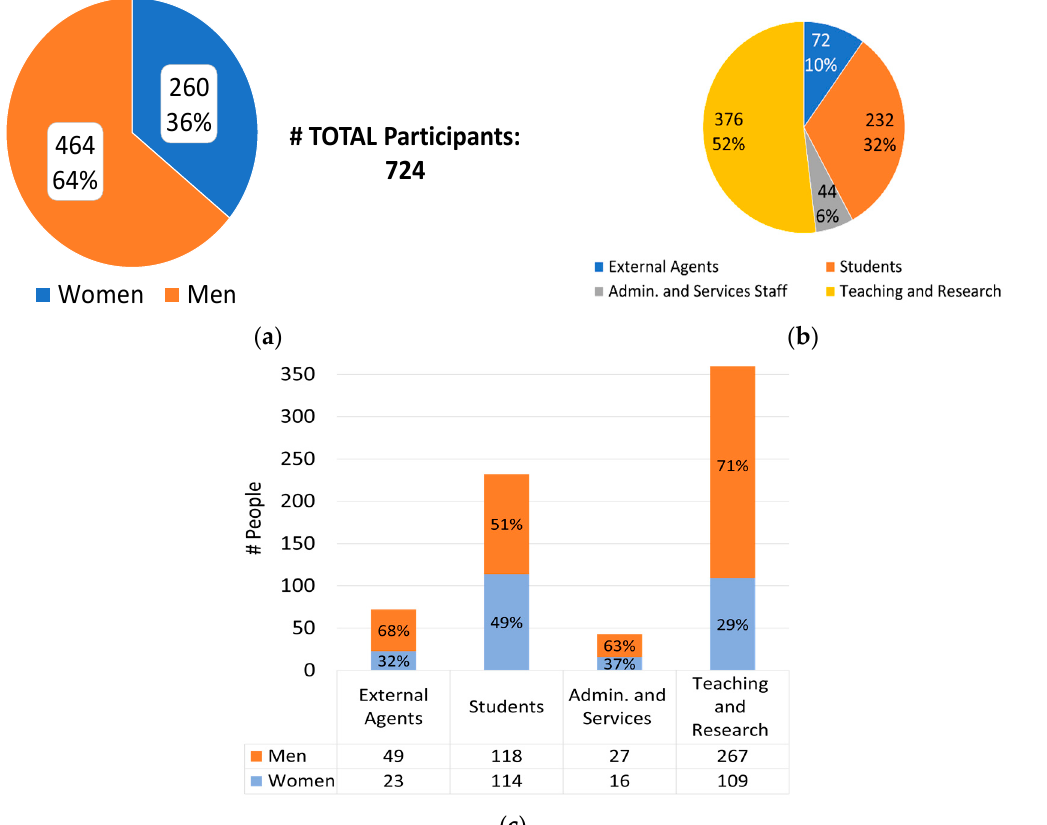
Figure 13. Number of participants in relation to gender ( a ), sector ( b ), and both ( c ).